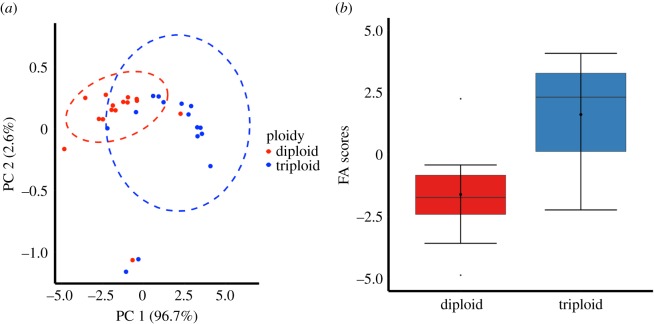
PCA of muscle tissue FA analysis with 0.95 confidence ellipses (a) and differences in principal component FA scores between 2-year-old diploid and triploid Atlantic salmon (b). Boxplots show median (horizontal black line) and mean (thick black dot); whiskers indicate points within the 1.5 IQR and quartile ranges (coloured box area).